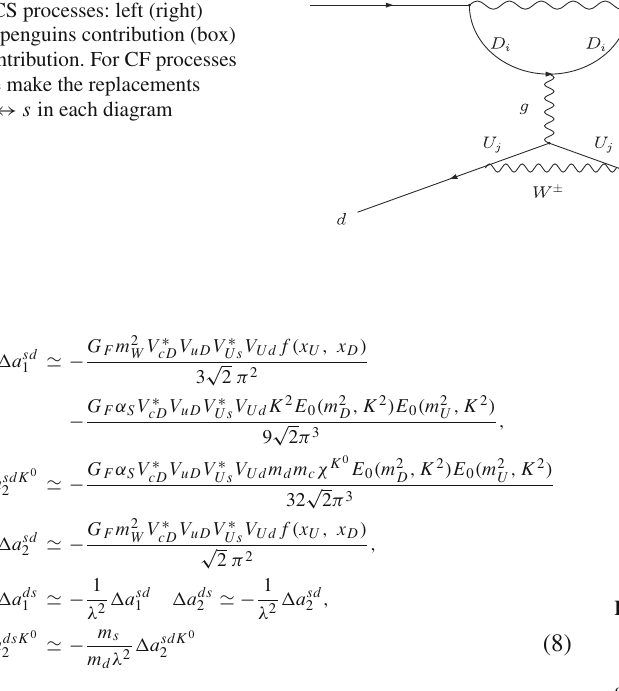
Fig. 1 Feynman diagrams for DCS processes: left (right) di-penguins contribution (box) contribution. For CF processes we make the replacements